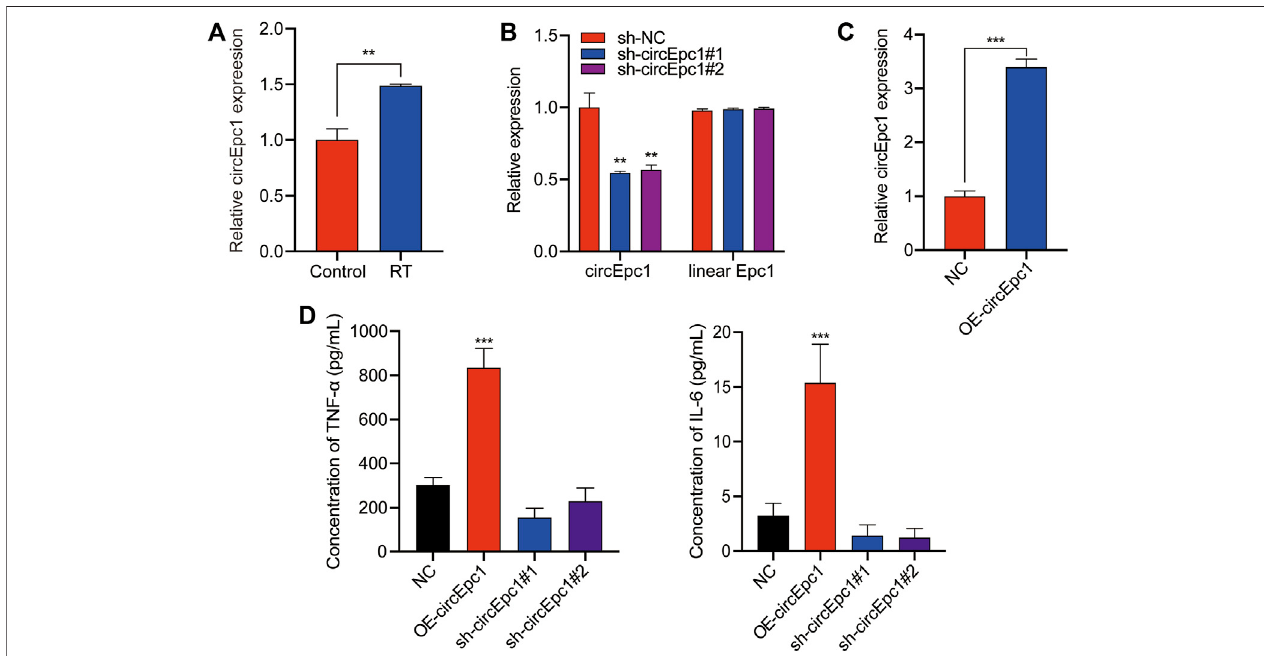
FIGURE 3 | Characterization of circEpc1 in RT-treated RAW264.7 cells. (A) Expression level of circEpc1 in control and RT-treated RAW264.7 cells. (B) Two shRNAsweredesignedtosilencecircEpc1bytargetingthesplicedjunctionofcircEpc1,itrevealedthattheshRNAscouldsigni fi cantlydownregulatetheexpressionlevel of circEpc1 but had no effect on that of linear Epc1. (C) Expression level of circEpc1 in RAW264.7 cells after transduction with over-expressing circEpc1 lentivirus. (D) ELISAassayswereperformedto determine the roleofcircEpc1inRT-induced in fl ammation. Datarepresent themean ± SD from three representativeexperiments (* p < 0.05, ** p < 0.01, *** p <